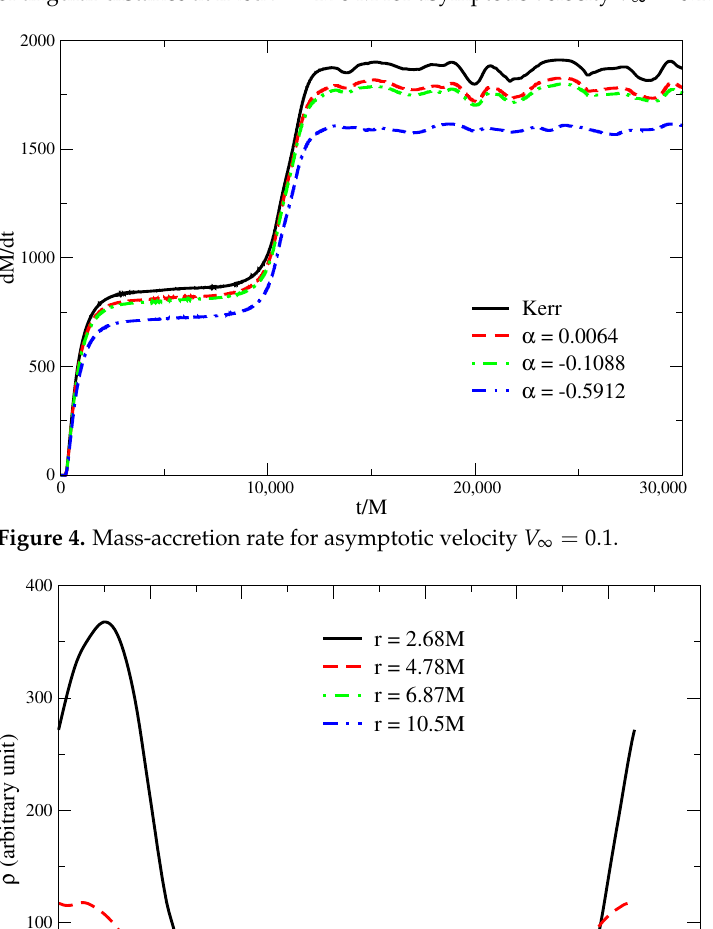
0.5912 at different r −